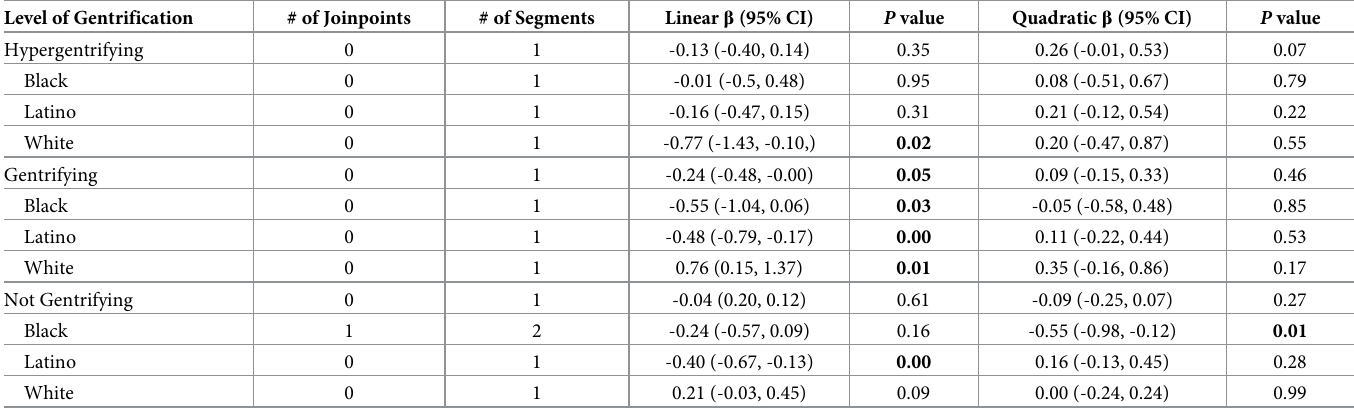
Table 1. The joinpoint regression trend shape, and logistic regression model slope, with linear and quadratic terms, of serious psychological distress prevalence by level of gentrification and stratified by race/ethnicity, New York City, 2002–2015.